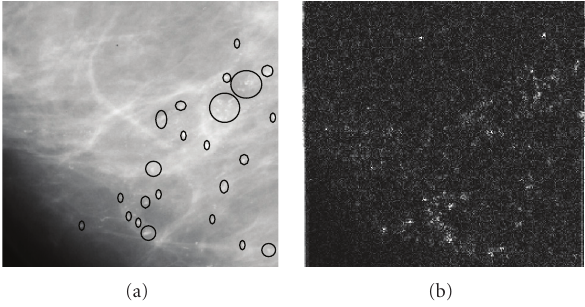
Figure 5: Synthesizing clustered microcalcifications: (a) original mammogram (b) mammogram with synthetic microcalcification, red circles correspond to the training samples of the microcalcifi- cations while yellow circles represent the training samples for the normal (or healthy) tissue.